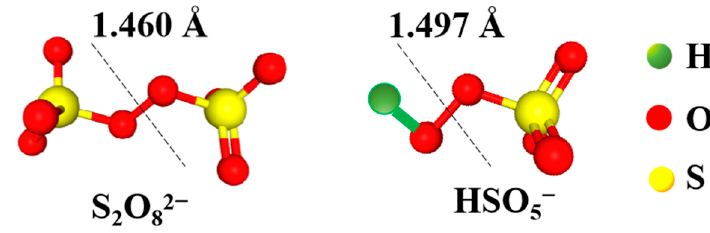
Figure 2. Chemical structures of S 2 O 82 − and HSO 5 − . Table 3. Properties of PDS and PMS.